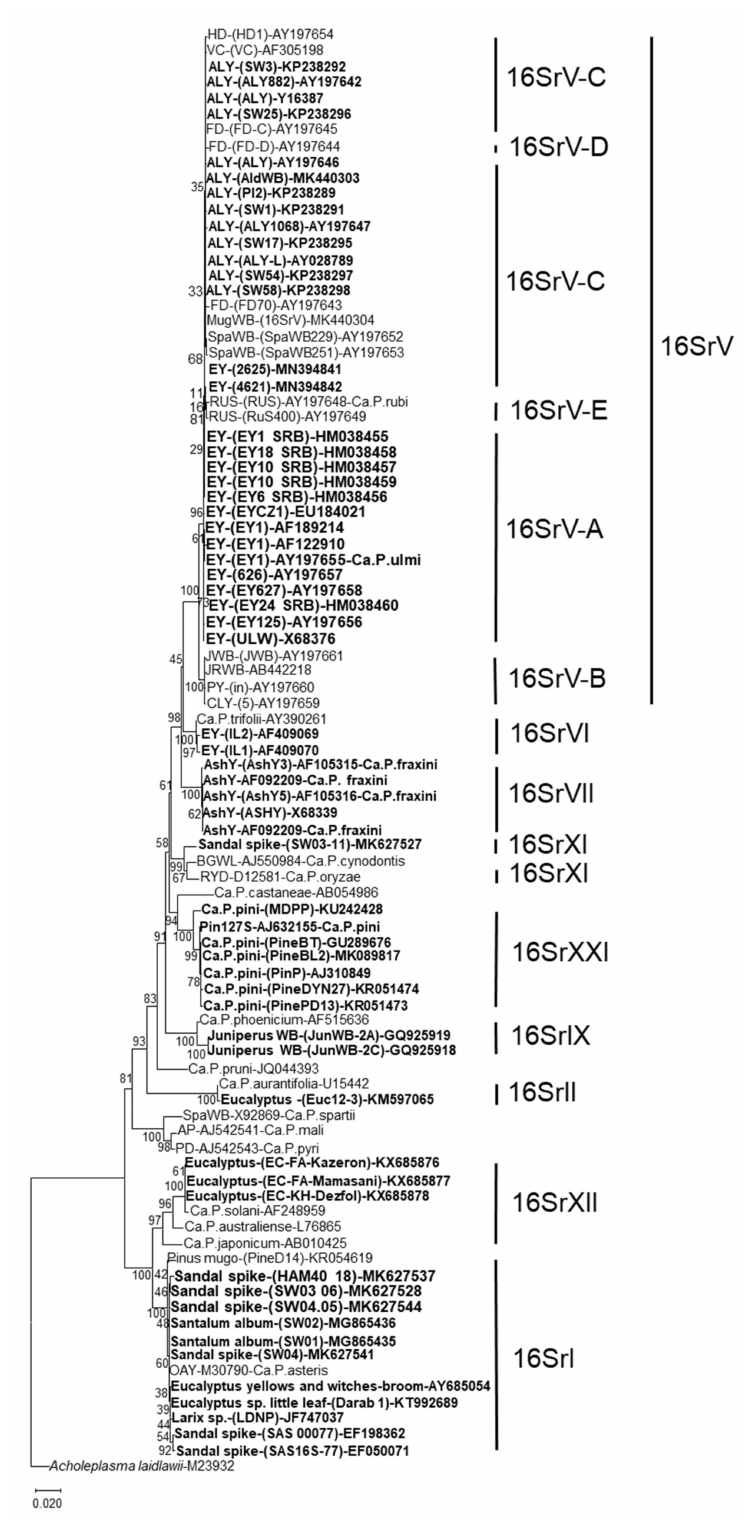
Figure 1. Phylogenetic dendrogram generated by using the neighbor-joining method software MEGA, version X [25] with 16S rDNA sequences from phytoplasmas detected in naturally infected elm, alder, ash, conifer, sandal and eucalyptus trees (in bold type), and a number of reference phytoplasmas. Acholeplasma laidlawii was used as the outgroup. Bar represents a phylogenetic distance of 2%. GenBank accession number is given for each phytoplasma. Bootstrap values are shown on branches of the